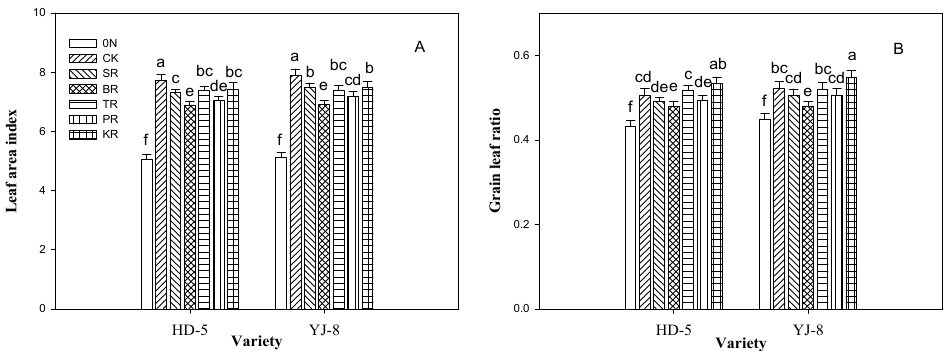
Figure 3. Leaf area index ( A ) and grain leaf ratio ( B ) of rice at the heading time under various N reduction treatments. Vertical bars represent ± standard error of the mean where these exceed the size of the symbol. Different letters above the column indicate statistical significance at the p = 0.05 level.